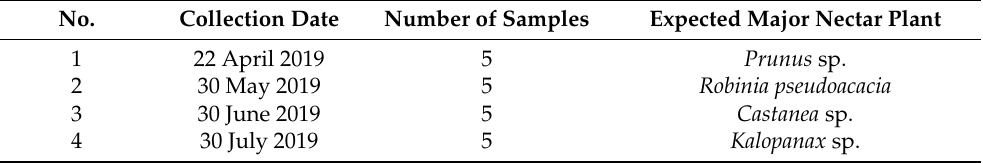
Table 1. Natural honey samples collected for identification of the nectar